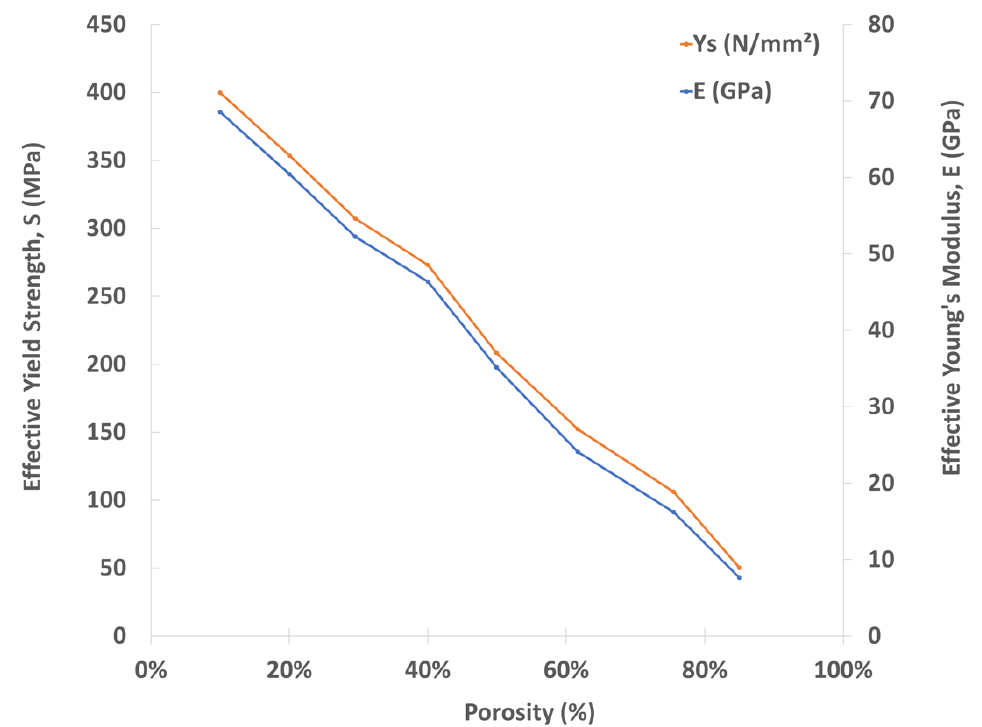
Figure 8. Effective yield strength and effective Young’s modulus with varying porosities obtained from the finite element simulation.